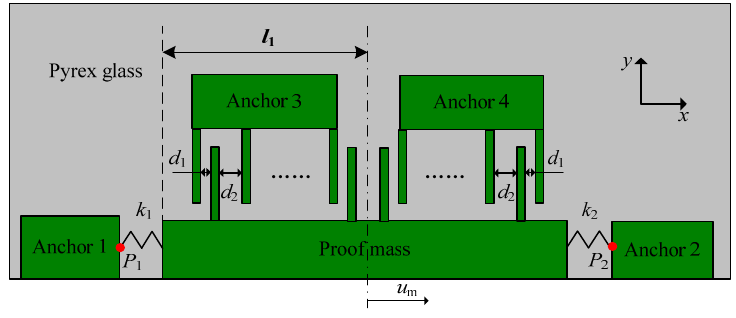
Figure 2. Half-structure of sensitive components.